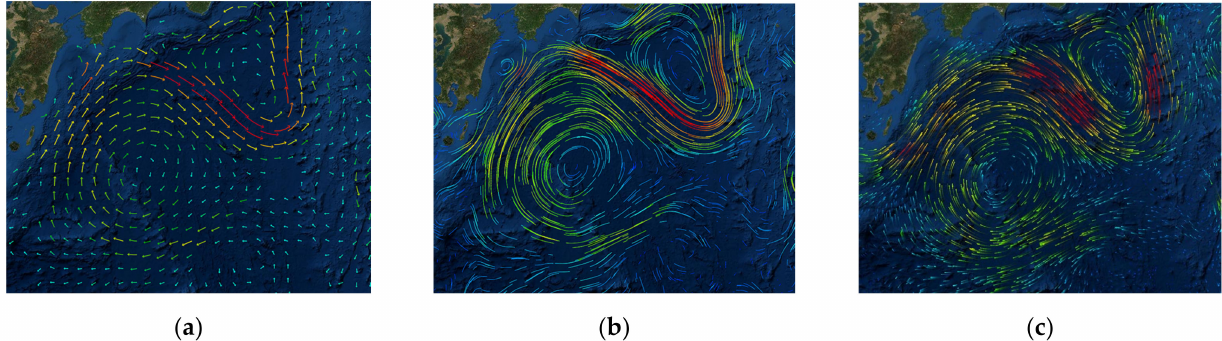
Figure 9. Current data representation is generated by different visualization methods at a viewing distance of 2000 km. ( a ) is the rendering for the direct visualization method ( b ) is the rendering for the geometric visualization method, and ( c ) is the rendering for the dynamic streamlet method based on the particle system.